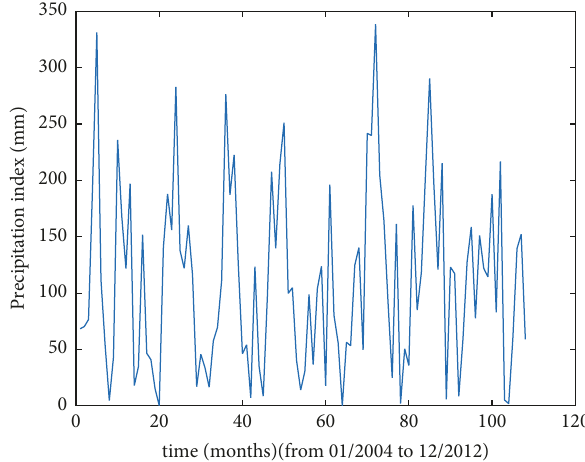
Figure 1: Precipitation index